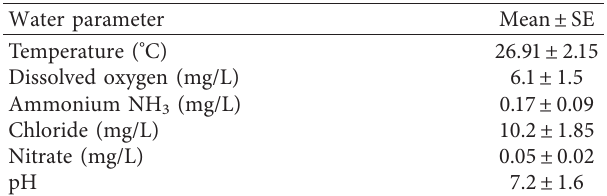
Table 1: The physical and chemical parameters of water (Mean- ± SE) measured during experimental